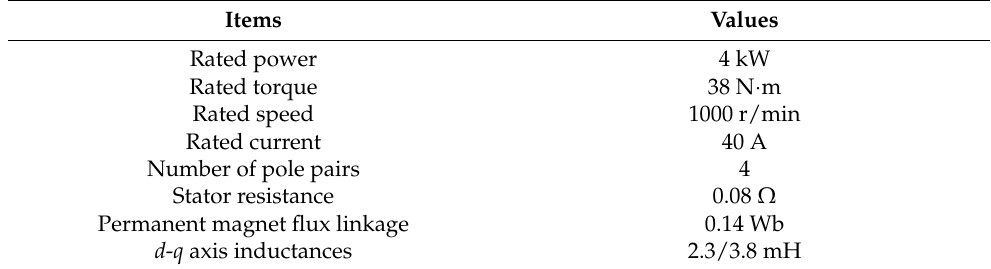
Table 1. Specification of the IPMSM. Items